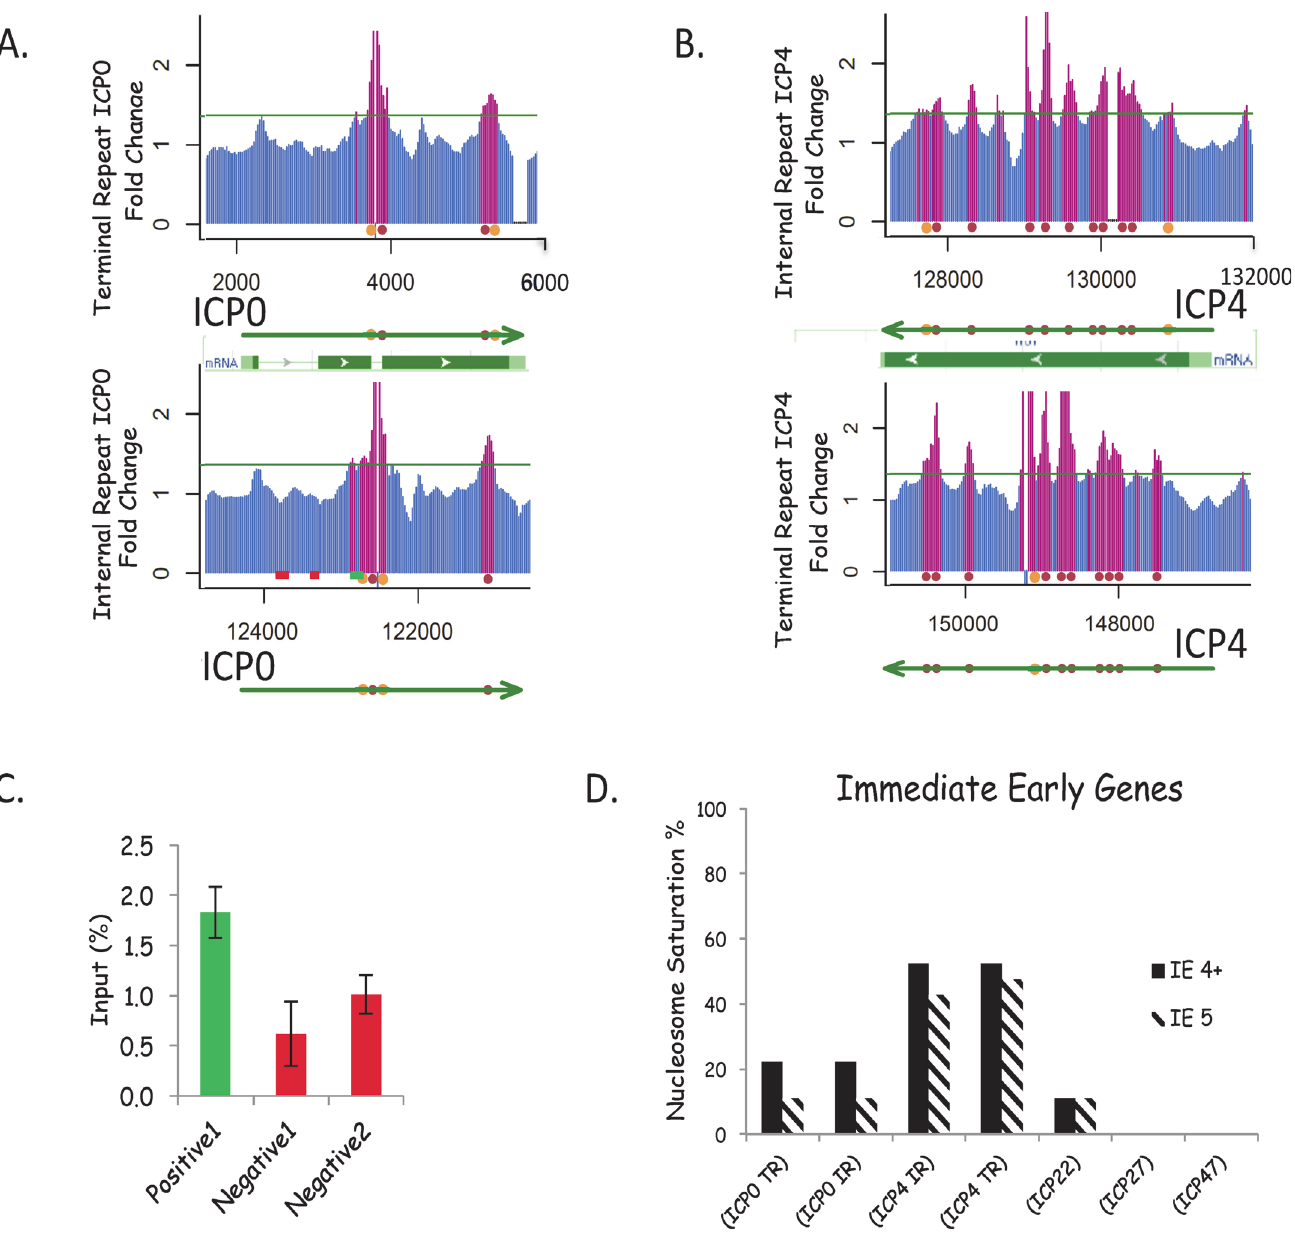
Fig 4. Nucleosomes on Immediate Early genes. A and B . The nucleosome signal is shown for the region covering two immediate early genes, which are diploid in the HSV-1 genome. The two gene copies have been inverted and aligned with each other to show that the array signal is similar but not identical. Spaces in the graph lines are “ poorly performing ” oligos where no signal could be measured. Between the array signal information we have mapped the transcribed gene (green). The red balls indicate the predicted position of nucleosomes with 5 consecutive positive hybridizing oligos. The orange balls indicate where we have inferred a nucleosome from 4 positive oligos and assumed there is a fifth positive oligo that is not recorded because of a “ poorly performing ” oligo, or some other technical problem. Gene features from the NCIB database are also shown. C To confirm our nucleosome positioning we used ChIP and Q-PCR (see Methods), selecting primers to amplify regions of ICP0 that we designated as having a probable nucleosome (green), or NFR (red). D . Nucleosome Saturation for each Immediate Early gene. The predicted number of nucleosomes for each IE gene were compared to the maximum number of nucleosomes possible (assuming a standard cell 200nt/nucleosome repeat pattern) to give the nucleosome saturation, which is expressed as a %.